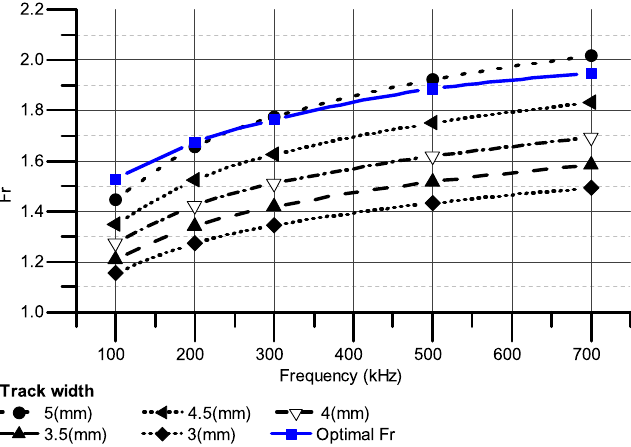
Figure 8. R AC / R DC of three-turn PCB windings with different track width.